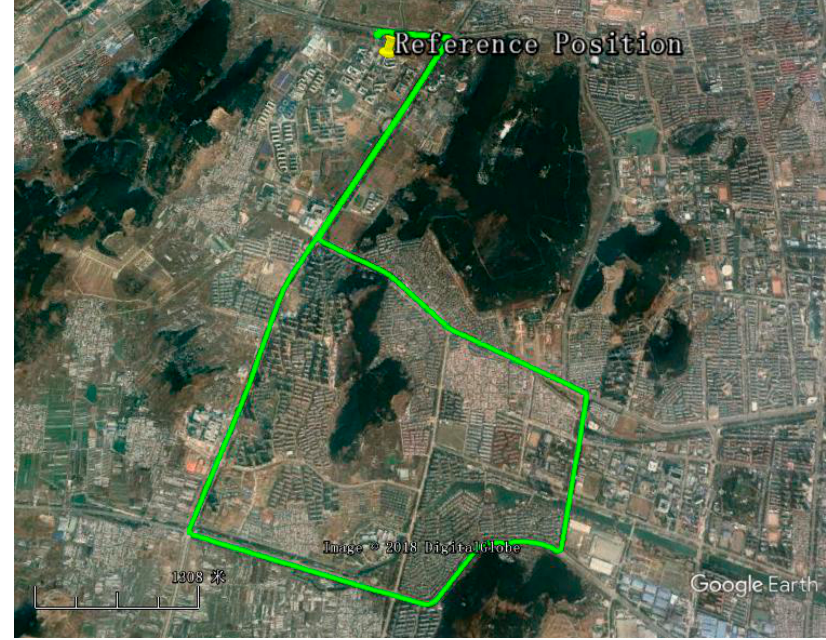
Figure 5. Ground track of field test.